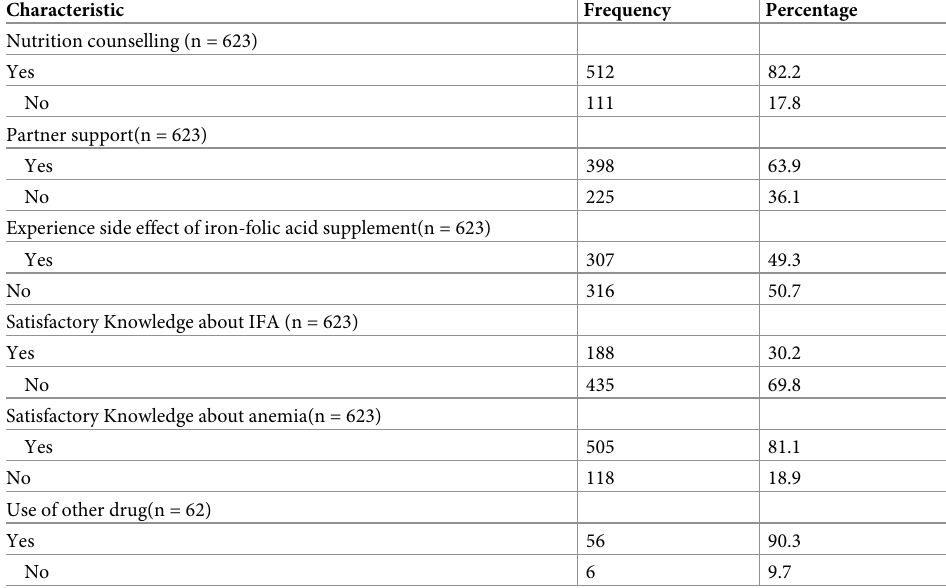
Table 3. Knowledge and supplement related characteristics of ANC attending pregnant mothers in governmental health institutions of Adwa town, Northern Ethiopia, 2018.